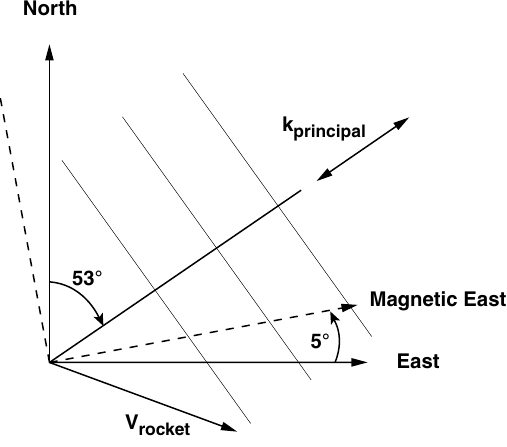
Fig. 11. The principal component of the observed, large scale elec- tric field wavevector for the upleg with respect to the horizontal rocket velocity and the horizontal magnetic field